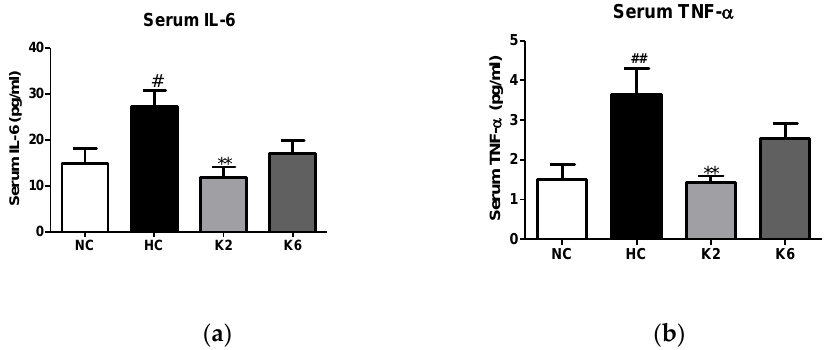
Figure 5. Effect of L. plantarum treatments on the production of cytokines in serum in the HFHF diet rat. Production concentrations of ( a ) IL-6 and ( b ) TNF- α in the serum. Values represent the mean ± SEM. # p < 0.05 and ## p < 0.01 vs. control group (NC), ** p < 0.01 vs. HC group. NC, normal diet control; HC, HFHF diet control; K2, HFHF diet with K2; K6, HFHF diet with K6; IL-6, interleukin-6; TNF- α , tumor necrosis